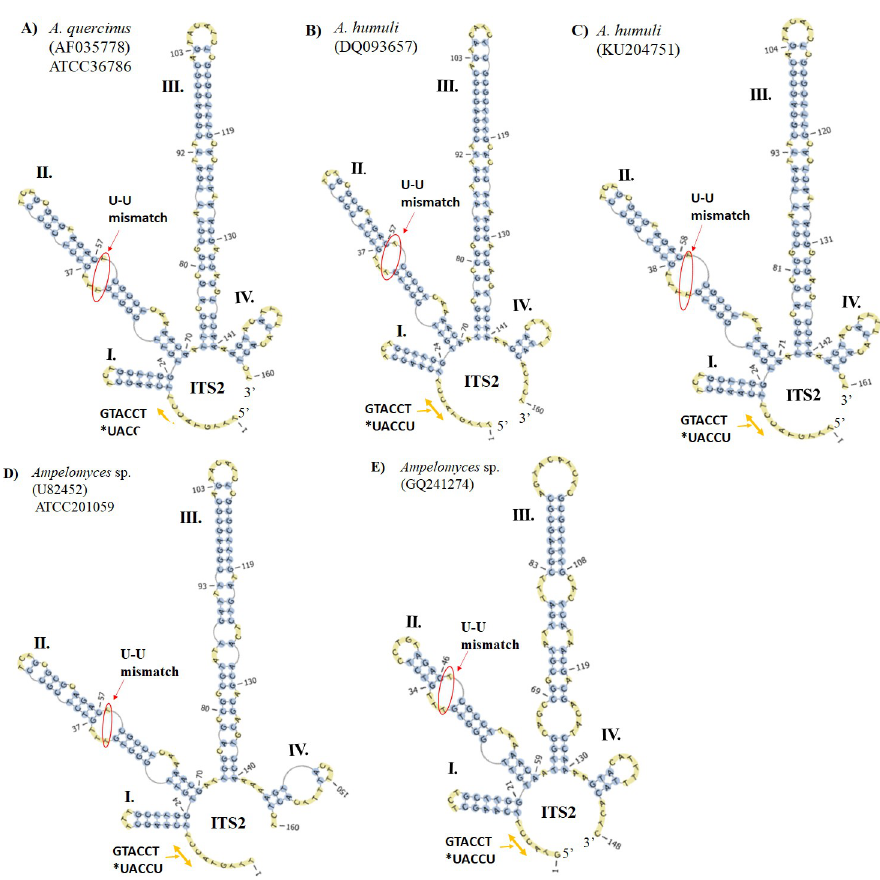
Fig 8. Predicted putative Ampelomyces ITS2 S2s were modelled to those from Didymella , Epicoccum and Phoma . (A) The ITS2 S2 from A . quercinus was homology modelled based on the ITS2 S2 from D . pomorum (FJ839851). (B) The ITS2 S2 from A . humuli were modelled according to the ITS2 S2 from Epiccocum sp. (GU973791) and (C) from the ITS2 S2 from D . glomerata (FJ839851). (D) The ITS2 S2 from putative Ampelomyces sp. (Group 1) was homology modelled based on the structure of P . labilis (GU237868). (E) The ITS2 S2 from putative Ampelomyces sp. (Group 2) extracted from crosstie waste was directly folded and modelled. The helices are indicated with Roman numerals (I–IV). The single-stranded ring between helices I and IV is indicated by orange left right arrows. The U-U mismatch on helix II is indicated with red arrows and circles. The S2s were obtained with the ITS2-DB. The last ITS2 sequences from Group 1 belonged to an Ampelomyces strain (U82452) extracted from G . cichoracearum infecting Cucurbita pepo ( Fig 8D ).This sequence was mod- elled with the structure of Phoma labilis (GI model: 294346519) and exhibited 98.8% identity. These results indicated that the Group 1 fungi are not related to the Ampelomyces lineages, but are related to the genera Didymella , Epicoccum and Phoma .